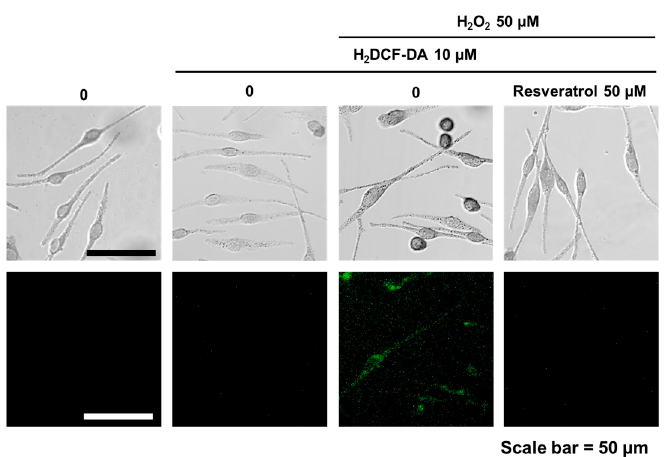
Figure 1. Fluorescent microscopic observation. After resveratrol (50 μ M, overnight) treatment, cells then treated by hydrogen peroxide (50 μ M, overnight). Fluorescent microscopic examination was done after H 2 DCF-DA (10 μ M) staining.